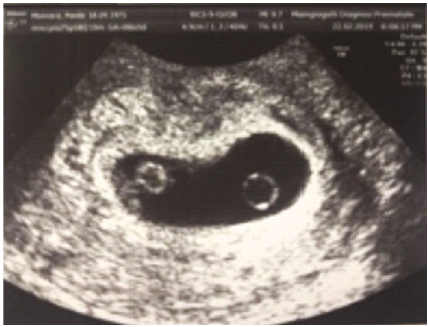
Figure 1: Two-dimensional scan showing three yolk sacs and a single